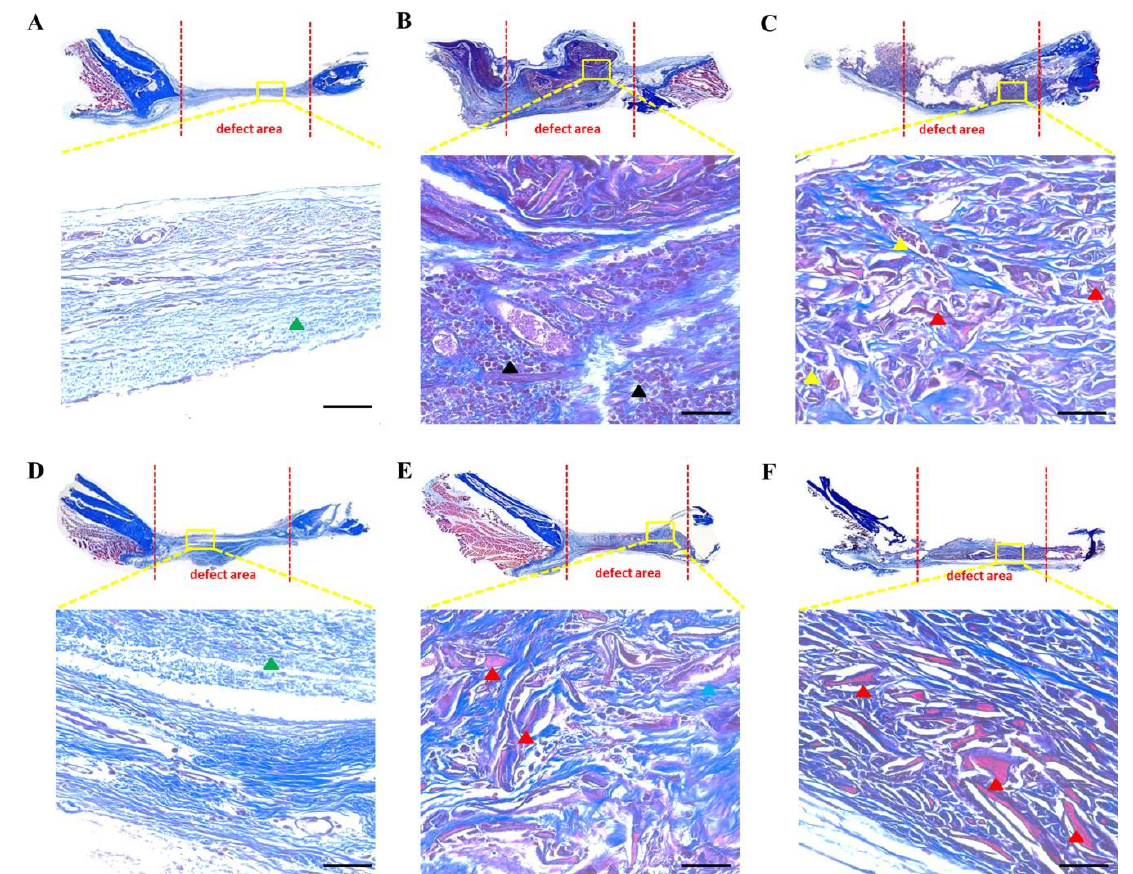
Figure 6. Masson's trichrome staining of rat calvarial defects in the control, implanted SF scaffold, and implanted SF-hASCs scaffold groups. ( A,D ) Control group at six and twelve weeks postimplantation, respectively; ( B,E ) SF group at six and twelve weeks postimplantation, respectively; ( C,F ) SF-hASCs group at six and twelve weeks postimplantation, respectively (green triangle = fibrous connective tissue; black triangle = osteoblast; yellow triangle = osteocyte; red triangle = new bone; scale bar = 50 μm).